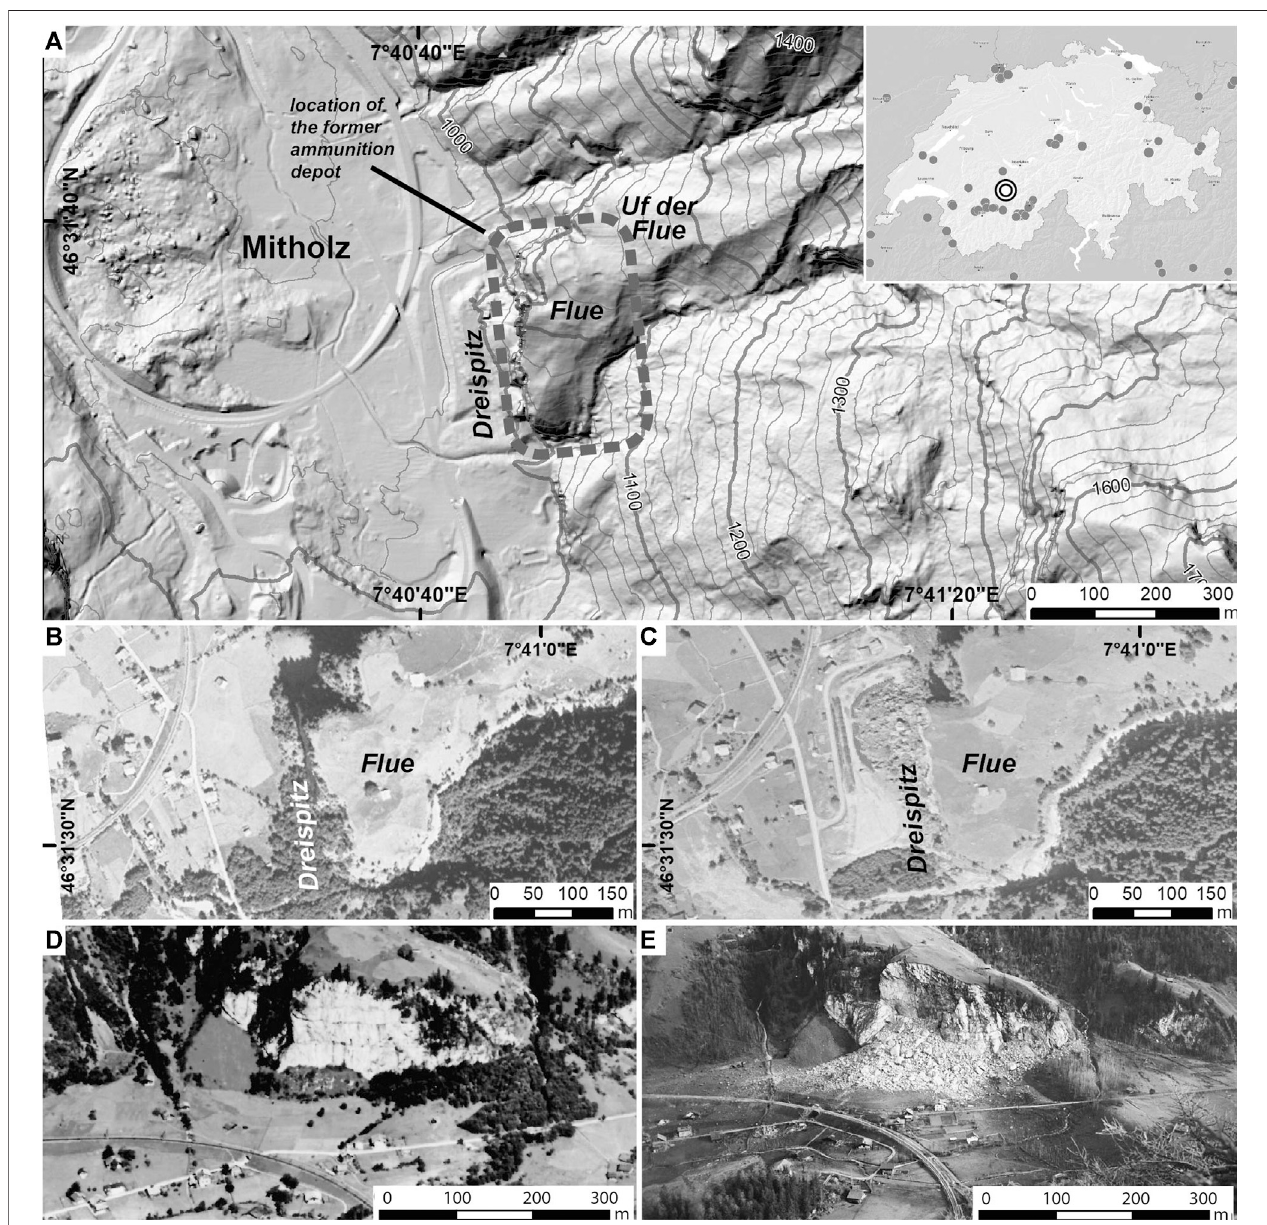
FIGURE 1 | Location and appearance of the Mitholz subsurface ammunition storage. (A) Digital elevation model of the surroundings of the former Mitholz ammunition depot with location names on the LiDAR-elevation-model from swissALTI3D from 2016; the insert shows the location of Mitholz (big circle) and of historic earthquakes (grey dots) larger than Magnitude fi ve in Switzerland (geodata source: Swiss Seismological Service and Earthquake Catalogue of Switzerland (ECOS-09); (B) aerialorthorecti fi edimageofApril1940beforetheammunitionstoragewasbuild(BundesamtfürLandestopogra fi eswisstopo); (C) aerialorthorecti fi edimageof September1960,13yearsaftertheuncontrolledexplosion(BundesamtfürLandestopogra fi eswisstopo); (D) aerialhistoricimageof ‘ Flue ’ beforetheconstructionofthe ammunition storage (year unknown, Aebi, 1969 picture 22,487); (E) historic aerial image of Mitholz after the explosions from January 8, 1948 (Aebi, 1969, picture